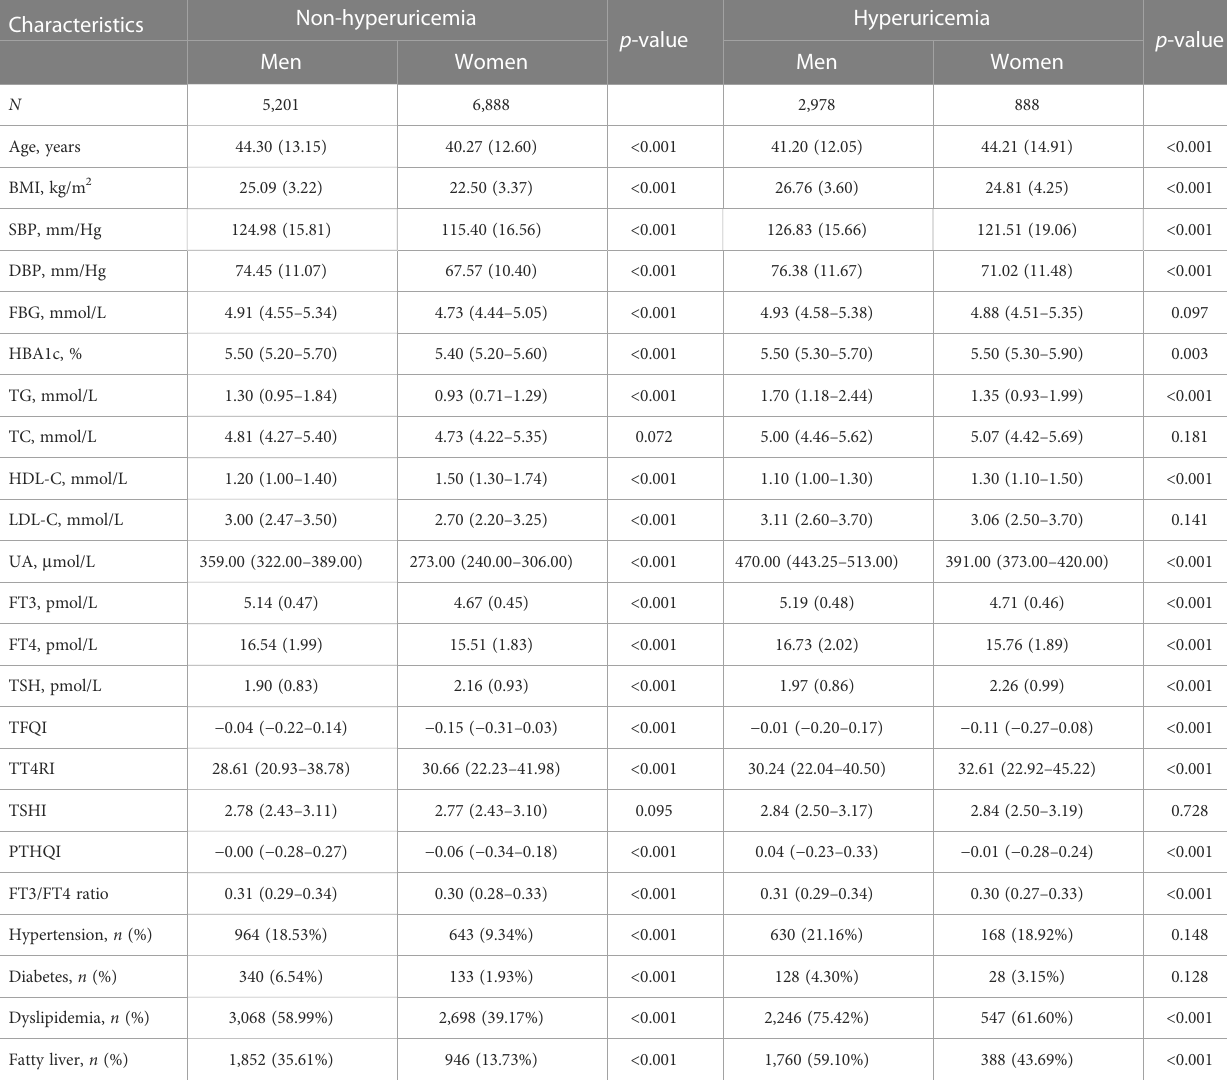
TABLE 1 Clinical characteristics of men and women with and without